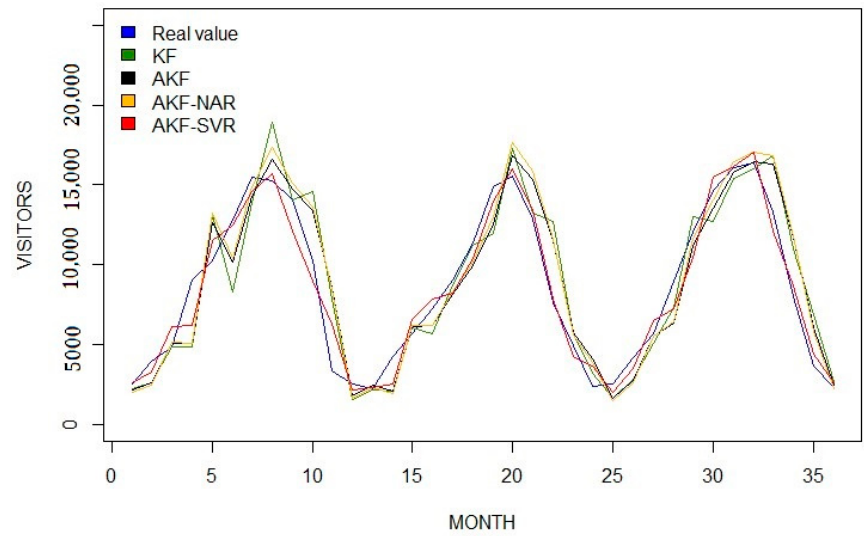
Figure 4. Prediction charts for total visitors in Huelva: 2017–2019 (monthly).